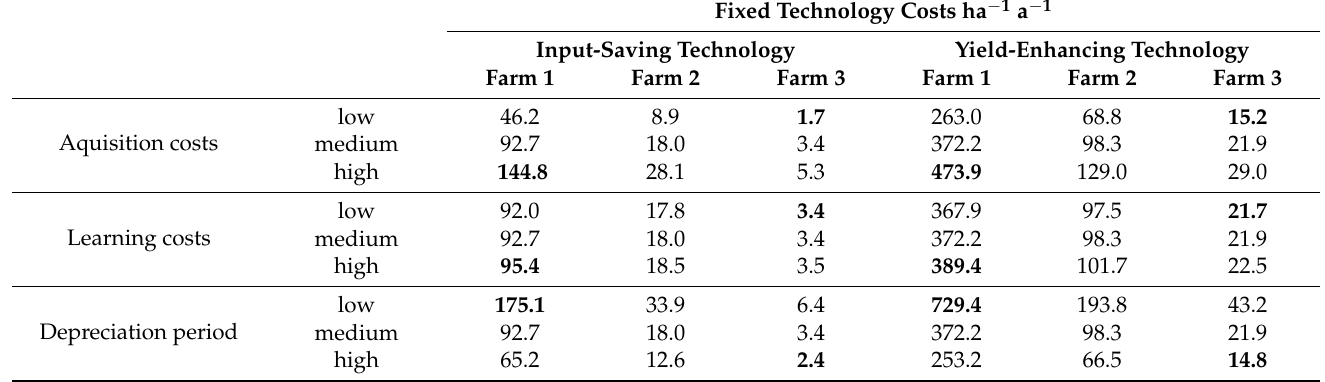
Table 2. Changes in the fixed technology costs of the input-saving and yield-enhancing technology (IST/YET) with changes in the acquisition cost, learning cost and depreciation